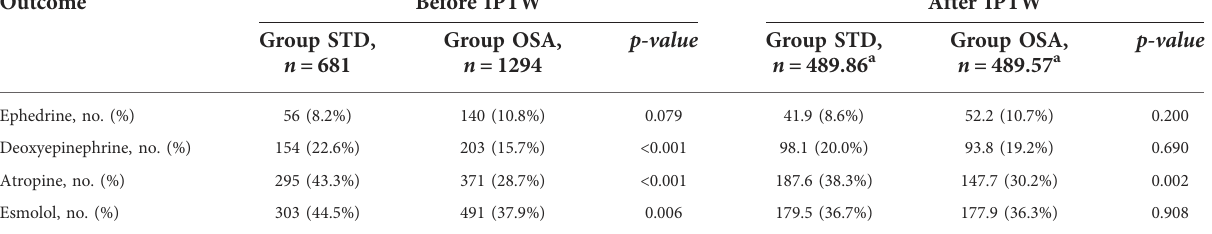
TABLE 3 Using of vasoactive drugs during